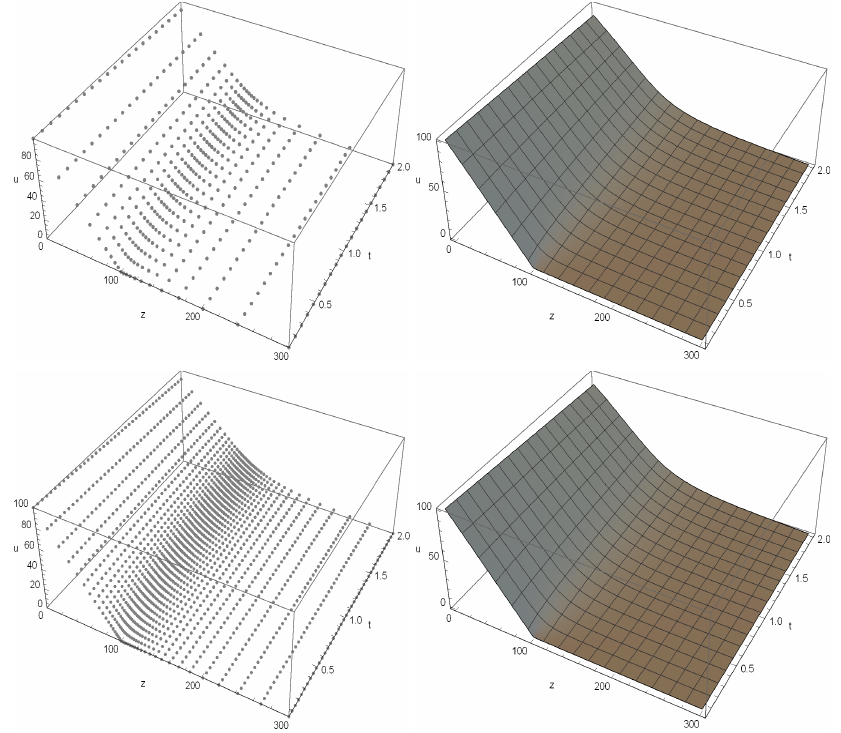
Figure 2. Computational illustrations in Example 2 for PMBS. Top Left : The point plot of the computational solution for m = n = 21. Top Right : The plot of the computational solution for m = n = 21. Bottom Left : The point plot of the computational solution for m = n = 41. Bottom Right : The plot of the computational solution for m = n = 41.